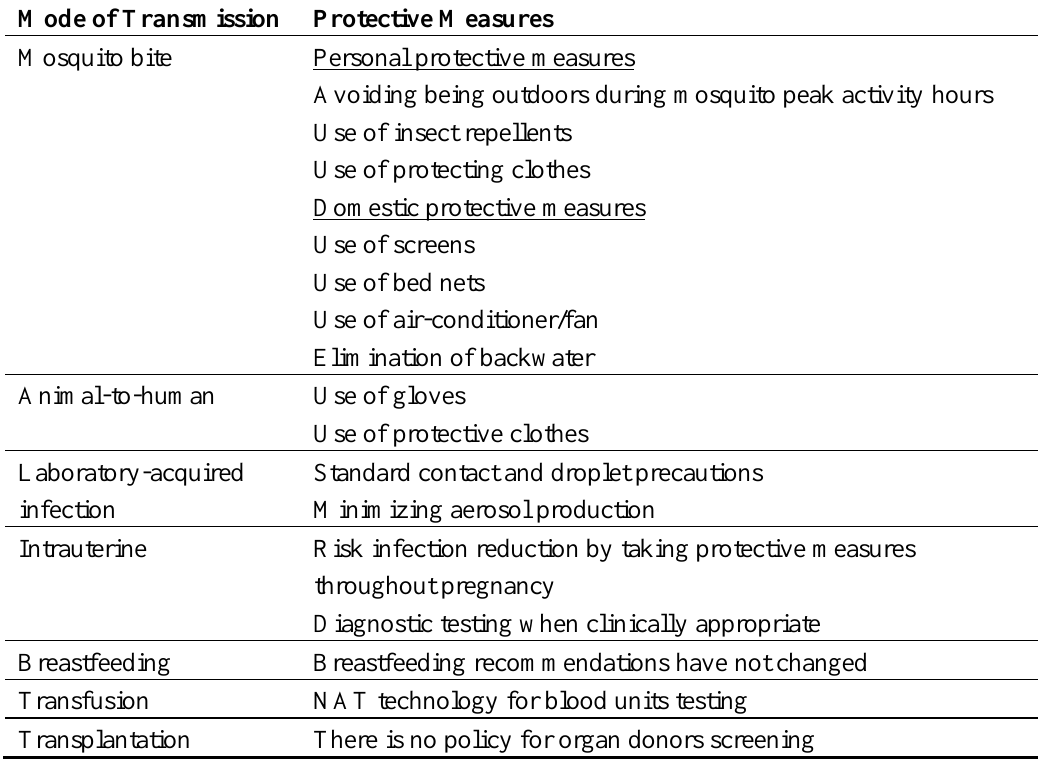
Table 3. Preventive measures for humans against